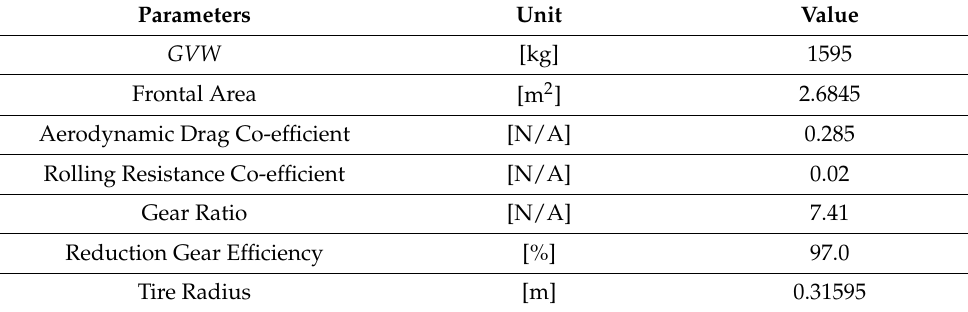
Table 3. Input parameters for vehicle performance simulation.